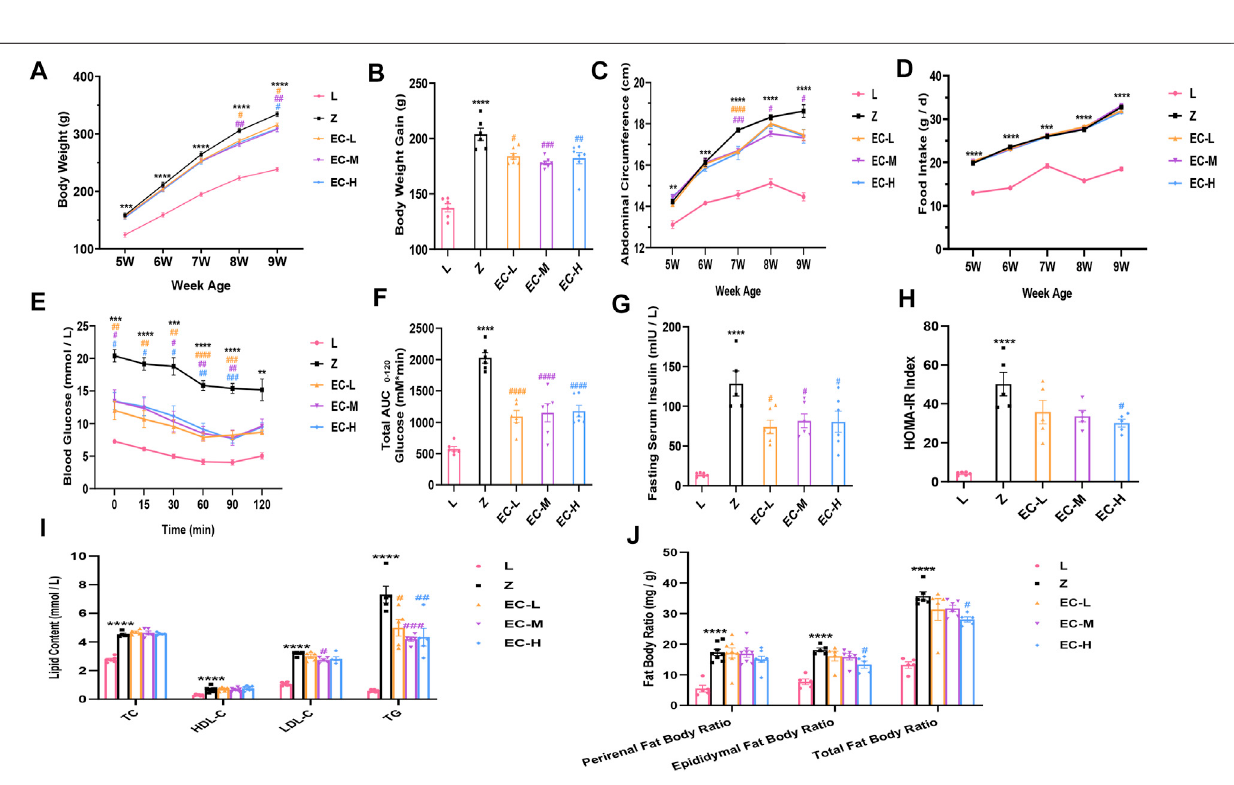
Frontiers in Pharmacology |